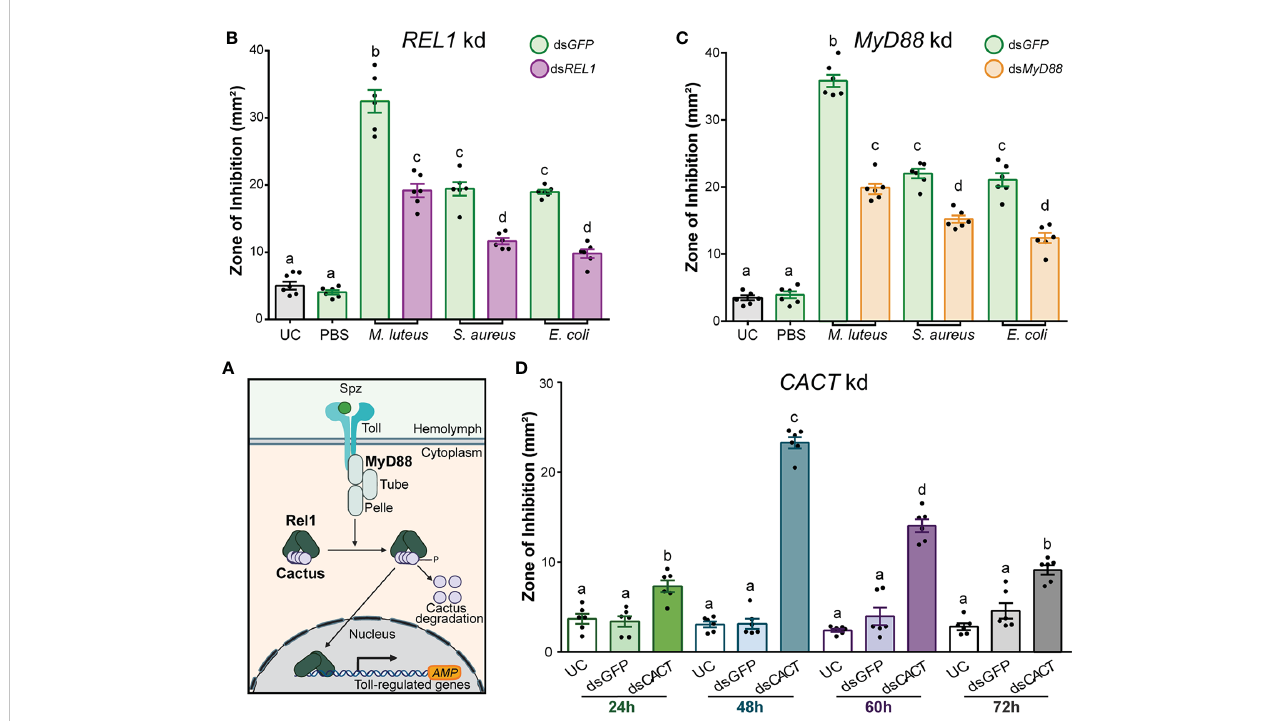
FIGURE 3 The antimicrobial activity of Anopheles gambiae hemolymph is regulated by the Toll pathway. (A) Overview of the Toll signal transduction pathway showing the known components that act as positive and negative regulators of the transcription of AMP genes in Anopheles gambiae . (B) Zone of inhibition produced by the hemolymph of ds REL1 -injected (B) and ds MyD88 -injected (C) mosquitoes. The mosquitoes were challenged 48 h after ds RNA injection with E coli , S. aureus , and M. luteus , respectively. Hemolymph was collected 24 h after challenge. Mosquitoes that were uninjected (UC) and injected with ds GFP prior to phosphate-buffered saline acted as negative controls, whereas those which had ds GFP injection prior to E coli , S. aureus , and M. luteus challenges acted as the corresponding positive controls. (D) The temporal variation of antimicrobial activity induction after CACT kd was determined by collecting hemolymph at 24, 48, 60, and 72 h after ds CACT injection. In (B) , (C) , and (D) , data are shown as means ±1 standard error ( n = 6). One-way ANOVA, followed by Bonferroni ’ s multiple-comparison post-test, was performed to calculate the statistical signi fi cance ( P < 0.05). Means with the same letter are not signi fi cantly